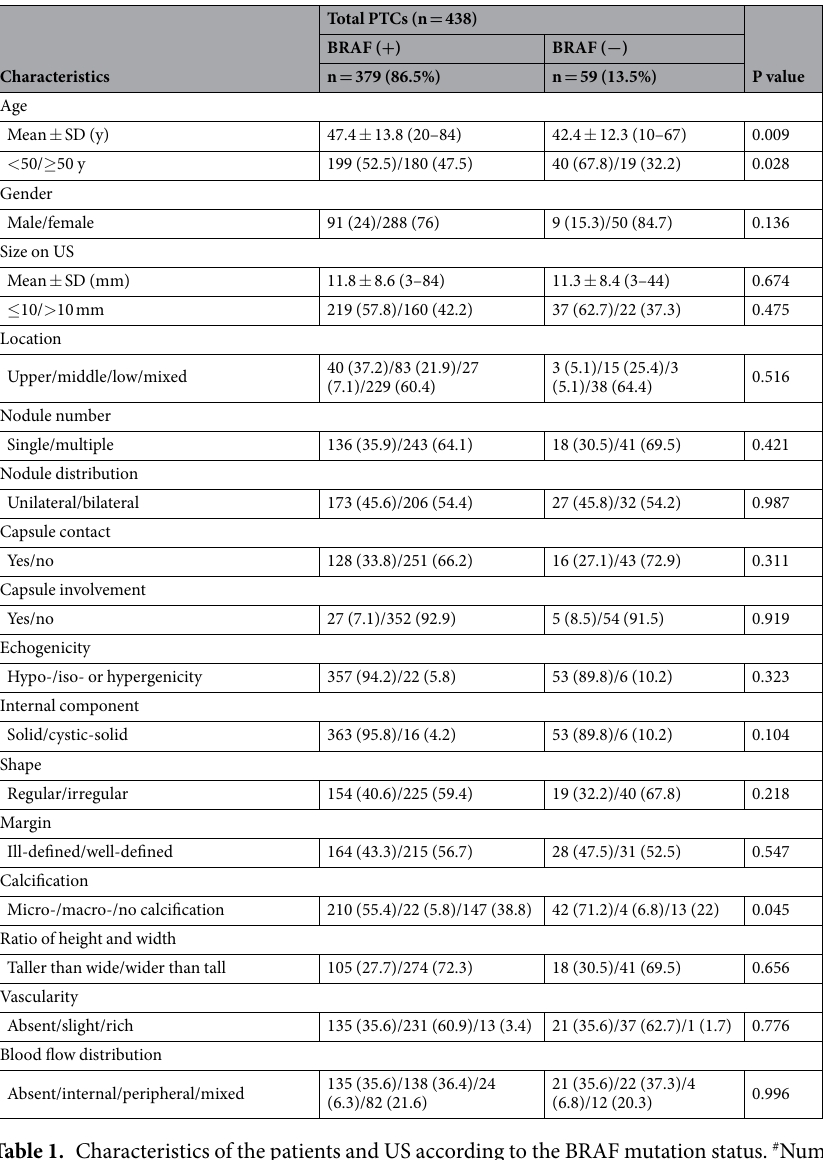
Table 1. Characteristics of the patients and US according to the BRAF mutation status. # Numbers in parentheses are percentages or ranges. US: ultrasound, PTC: papillary thyroid carcinoma.